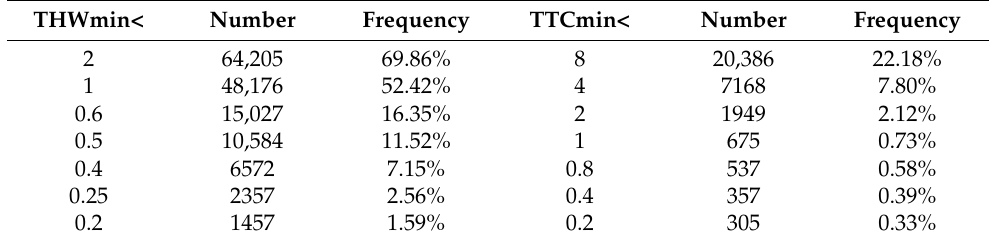
Table 2. Frequency of THWmin and TTCmin in defined